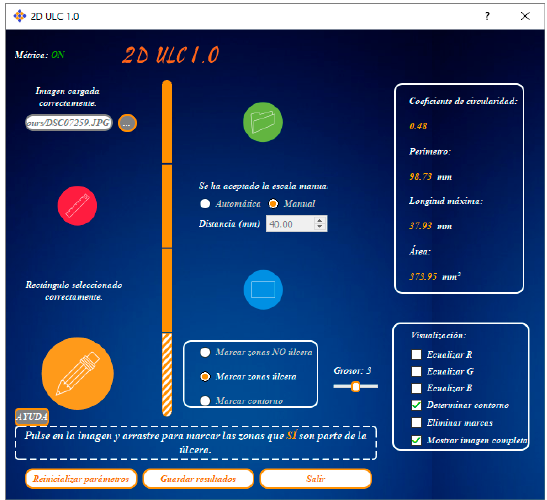
Figure 1. Application 1 user interface